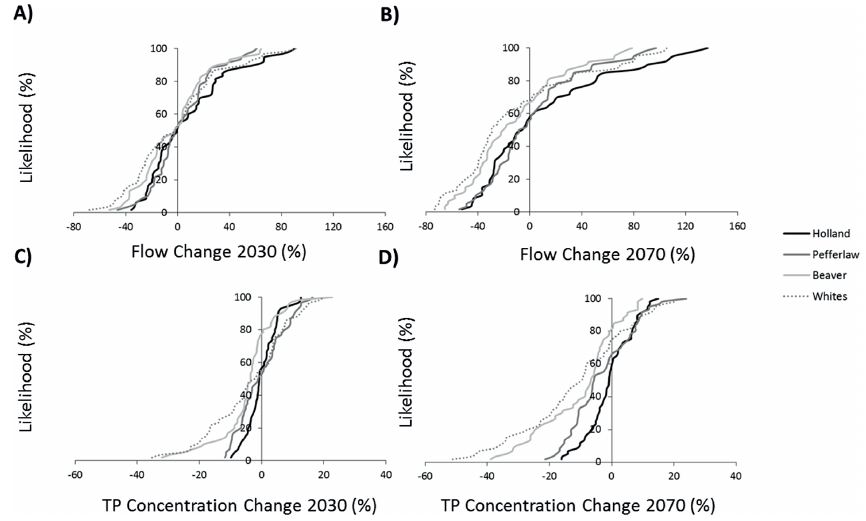
Figure 10. Between-catchment comparison of the CDFs from the perturbed physics ensemble of (a) monthly change in flow by 2030, (b) monthly change in flow by 2070, (c) monthly change in total phosphorus (TP) concentration by 2030, (d) change in TP concentration by 2070 (CDF: cumulative distribution